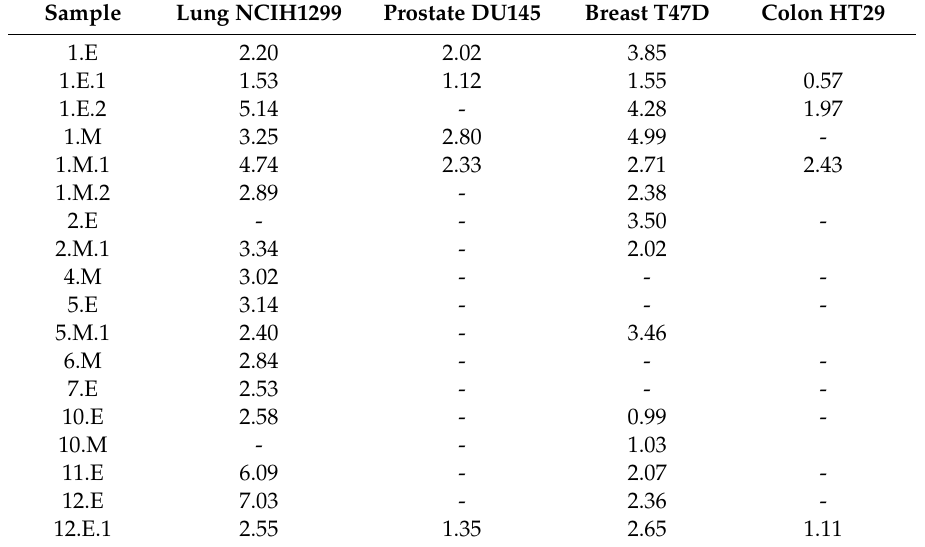
Table 3. Selectivity index (SI) values of samples showing anticancer activity against the cancer cell line